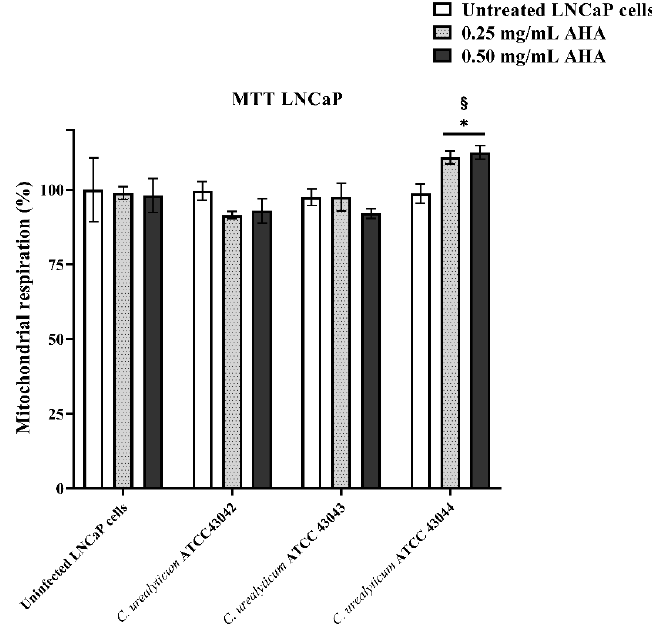
Figure 2. Effects of C. urealyticum infections and AHA treatments on LNCaP (lymph node carcinoma of the prostate) cell viability. Histograms show mitochondrial respiration rate of LNCaP cells grown in absence (uninfected LNCaP cells) or presence of C. urealyticum strains (ATCC 43042; ATCC 43043; ATCC 43044), without (white histograms) or with two different concentrations (0.25 µg/mL light grey histograms with dots and 0.50 µ g / mL black histograms) of AHA for 24h. Results are expressed as percentage. The bars represent means ± SD of three independent experiments performed in triplicate (SD = standard deviation). Statistically significant differences, determined by two-way analysis of variance ANOVA, are indicated: * p < 0.05 versus untreated; § p < 0.05 versus uninfected.